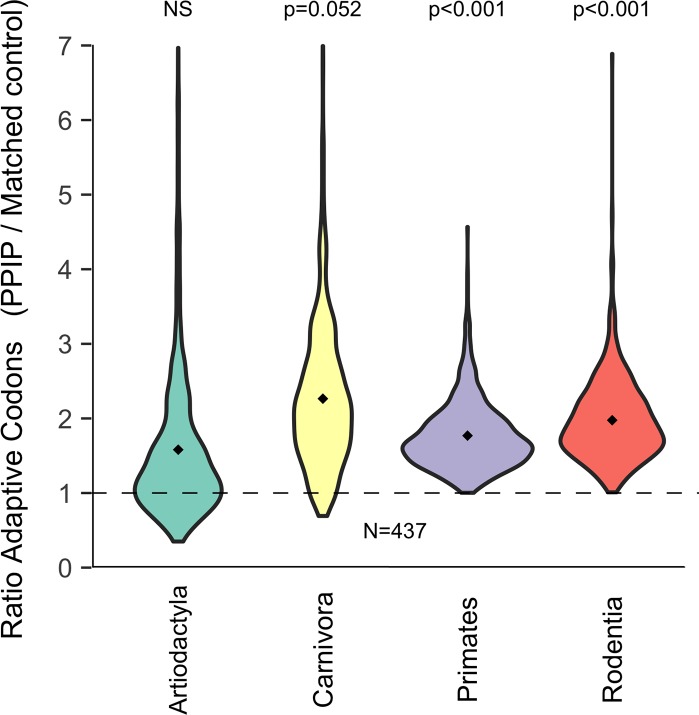
PPIP adaptation is widespread throughout mammals.Each violin plot depicts a set of 1000 ratios comparing the mean proportion of adaptive codons in PPIPs to that in 1000 sets of matched controls. Adaptive codons per gene are an average across all branches contained in the specified clade. The dashed line indicates the null 1:1 expectation for PPIPs:matched controls.